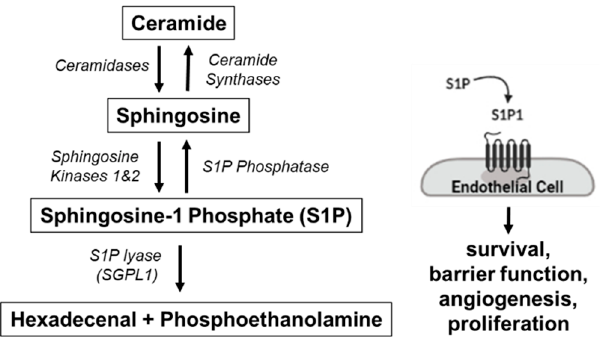
Figure 1. Sphingosine Metabolism. Sphingosine, produced by ceramide hydrolysis via ceramidase, is phosphorylated by sphingosine 1 kinase to generate sphingosine 1 phosphate (S1P), which promotes endothelial cell survival via S1P receptor 1 (S1P1). S1P is irreversibly degraded by S1P lyase (SGPL-1).